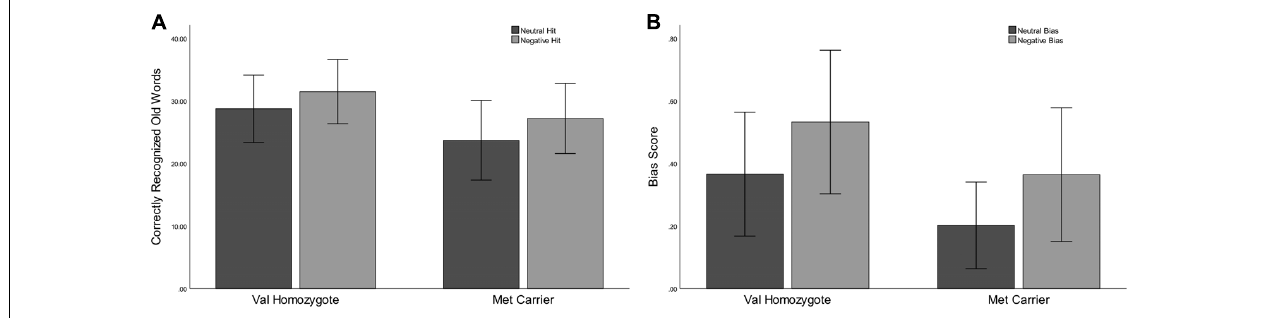
FIGURE 1 | Experiment 1: Mean recognition accuracy as a function of valence for Val homozygotes (left within graph) and Met carriers (right within graph) (A) . Mean bias score as a function of valence for Val homozygotes (left within graph) and Met carriers (right within graph) (B) . Error bars show 1 standard deviation of the mean.